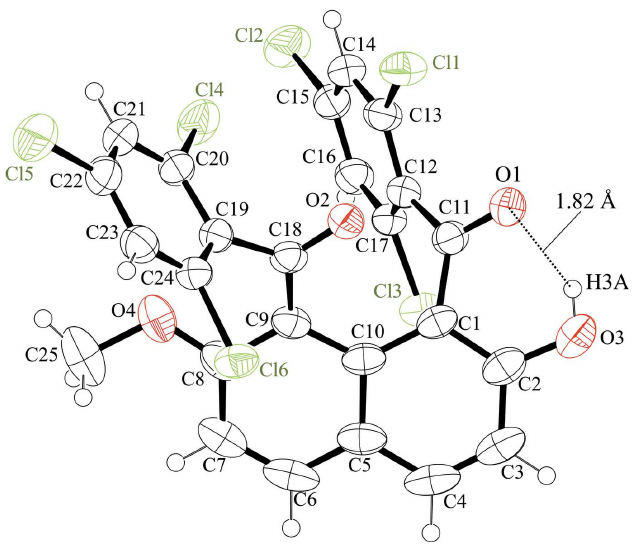
Figure 2 View of the title compound showing the intramolecular contacts; top view (left) and side view (right).